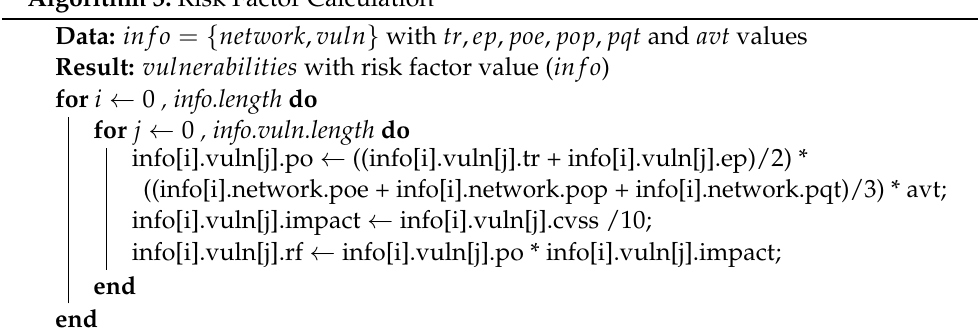
Algorithm 3: Risk Factor